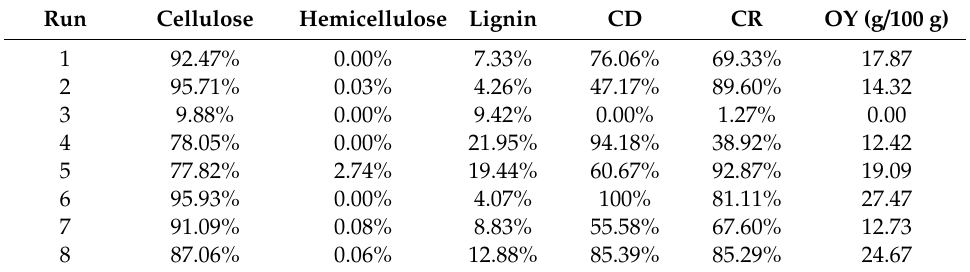
Run Cellulose Hemicellulose Lignin CD CR OY (g / 100